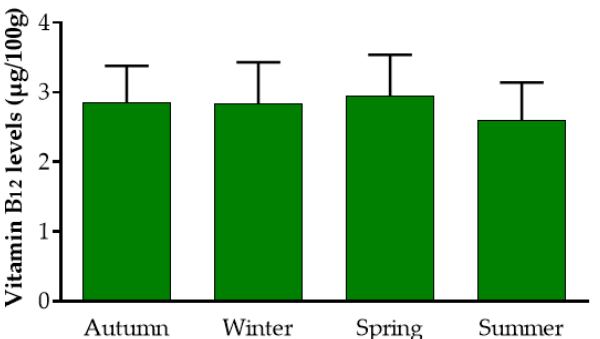
Figure 1. Stability of vitamin B 12 levels in Mankai™ along the year. “Autumn” refers to water temperatures of 22–24.5 °C and 10:20-10:50 h of light. “Winter” refers to water temperatures of 17–20 °C and 10–10:20 h of light. “Spring” refers to water temperatures of 21–24 °C and 11:30–13:30 h of light. “Summer” refers to water temperatures of 25–29 °C and 13:50–14:15 h of light. For each season, the weekly average water temperatures and daily light hours relate to the sampling date.